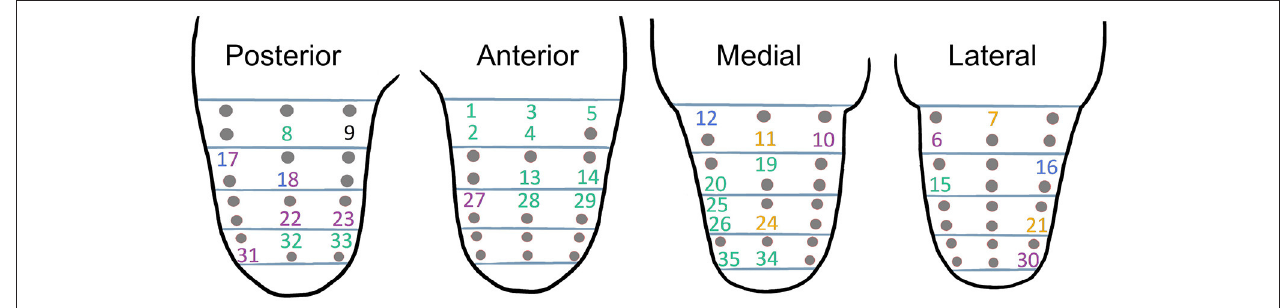
FIGURE 6 | Mapping of referred sensations (RS) on 4 sides of the residual limb (from left to right: posterior, anterior, medial and lateral side). The grey dots indicate the areas that did not give rise to the RS; the numbers those that did. The color of the numbers indicates the nature and the location of the RS (green: contraction of the calf; yellow: influx in the calf; blue: tingling in the foot; purple: influxes in the foot). Pressure on area 9 evoked a sensation that was too brief and weak to be identified, and on areas 17 and 18 an impulse and tingling in the foot.